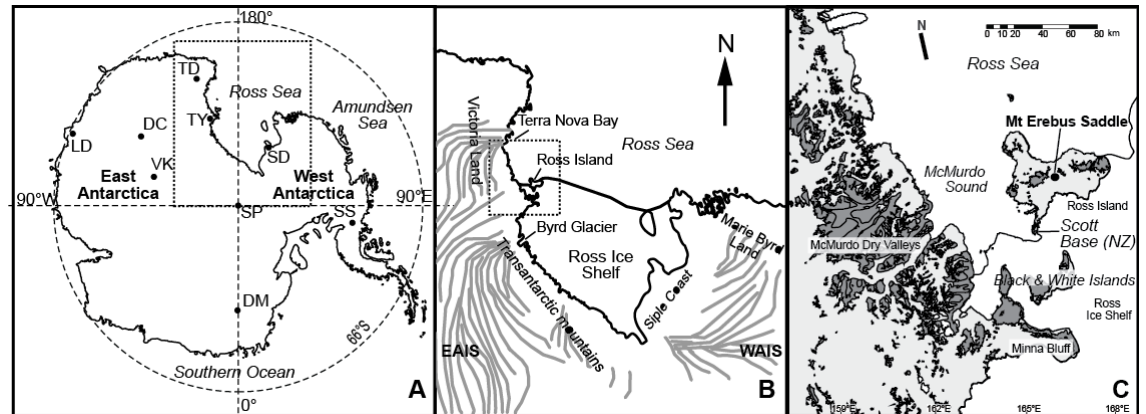
Fig. 1. (A) Map of the Antarctic continent. Locations of major ice core sites are marked by solid black circles and are labelled as follows: DC=EPICA Dome C; DM=EPICA Dronning Maud Land; LD=Law Dome; SD=Siple Dome; SP=South Pole; SS=Siple Station; TD=Talos Dome; TY=Taylor Dome. The dashed rectangle defines the area of map B. (B) Map of the Ross Sea region bound by the East Antarctic Ice Sheet (EAIS) and the West Antarctic Ice Sheet (WAIS). Approximate katabatic flow paths are indicated by grey arrows (modified after Parish, 1988). The dashed rectangle defines the area of map C. (C) Map of McMurdo Sound area. The location of Mt. Erebus Saddle (MES) is shown. Dark grey shading indicates areas of exposed rock outcrop.